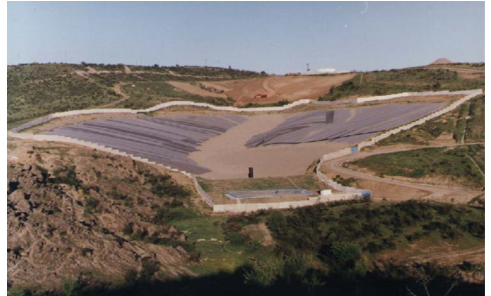
Figure 2. General view of the regional nonhazardous waste landfill site, town of Harmanli.